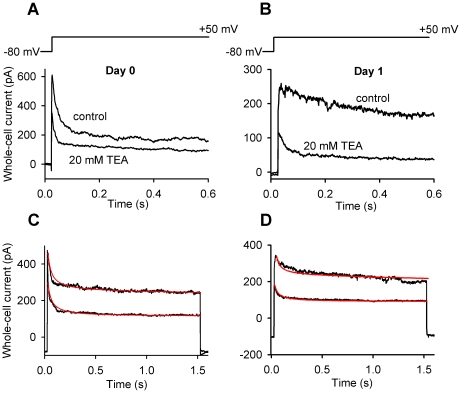
Changing kinetics and TEA-sensitivity of the K+ current during differentiation can be reproduced by simulated current traces.Whole-cell K+ currents recorded from a chondrogenic cell on the day of isolation (A) and on day 1 of culturing (B) in the absence and presence of 20 mM TEA. Currents were elicited by 1.5 s-long depolarizing pulses to +50 mV from a holding potential of −80 mV. For clarity the first 600 ms are shown. (C and D) Whole-cell K+ currents were modeled as the sum of currents through three different K+ channels: KV1.1, KV4.1 and a voltage-independent, possibly 2-pore channel. Simulations were based on the TEA sensitivity and inactivation kinetics. Calculated current traces with red lines are overlaid on recorded traces in the absence and presence of 20 mM TEA. The free parameters were the relative contributions of each channel type to the total whole-cell K+ current. Although more current components may also contribute, traces could be adequately reproduced by these three components. Traces on panels C and D are identical to those on panels A and B, respectively. The non-inactivating voltage-independent current component determined from the simulation was subtracted from the traces on panels A and B.